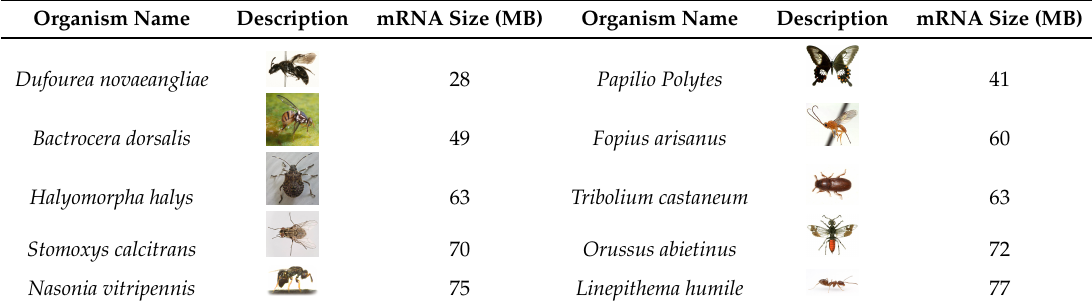
Table 2. Experimental